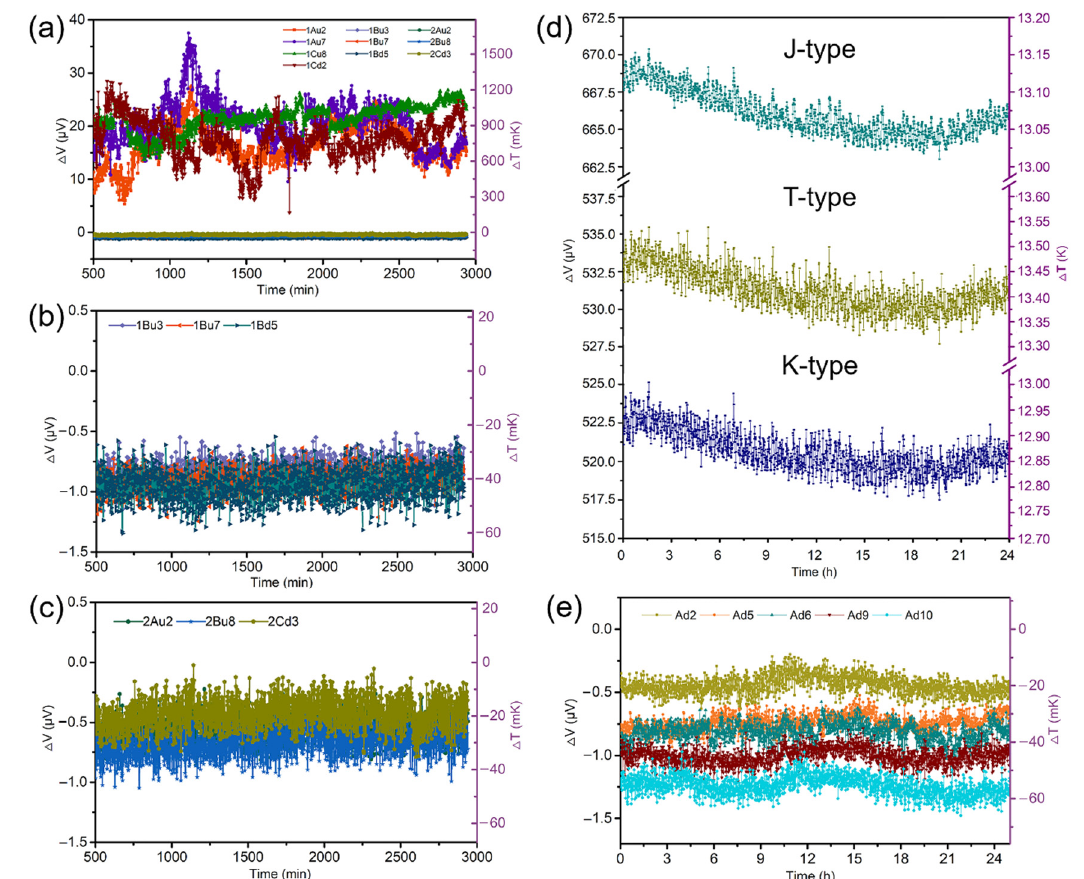
Figure 3. The high thermal sensitivity and low thermal noise of the cellular temperature-monitoring chip and system. ( a ) Background-temperature curves from the developed chips. ( b ) Comparing the output thermoelectric signals from the temperature sensors on freestanding Si 3 N 4 platform and on solid Si 3 N 4 /Si/Si 3 N 4 substrate exposed to a HeLa cell culture and to a blank control group without cells shows the high thermal sensitivity of the chips. ( c ) Enlarged temperature curves of HeLa cells obtained from the sensors on the Si 3 N 4 /Si/Si 3 N 4 substrates show a low temperature sensitivity. ( d ) Thermal-noise test results for three standard commercial thermocouples. ( e ) Thermal-noise test results for the developed chips with Pd–Cr TFTC sensors on a freestanding Si 3 N 4 platform.